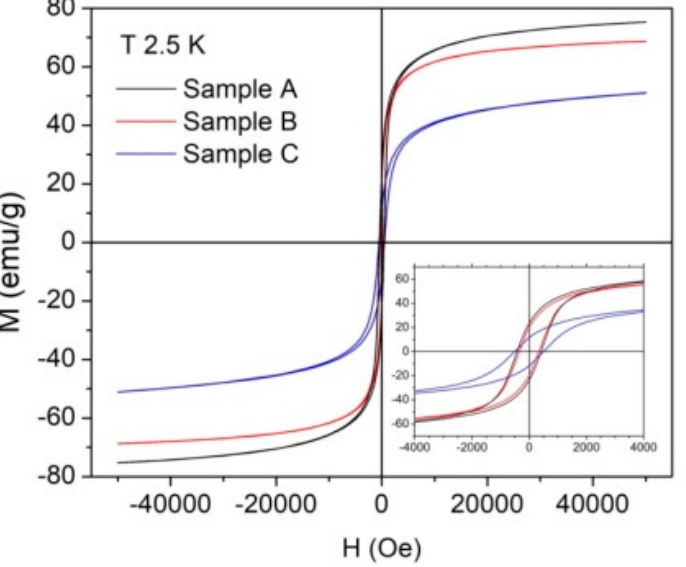
Figure 5. Magnetization vs. magnetic field intensity curves of samples A, B and C measured at 2.5 K. In the inset an enlarged region around the zero of the magnetic field intensity is shown.